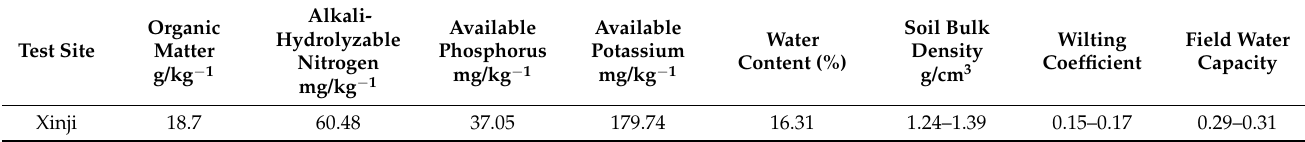
Table 2. Physical and chemical properties of soil at the Xinji test site.